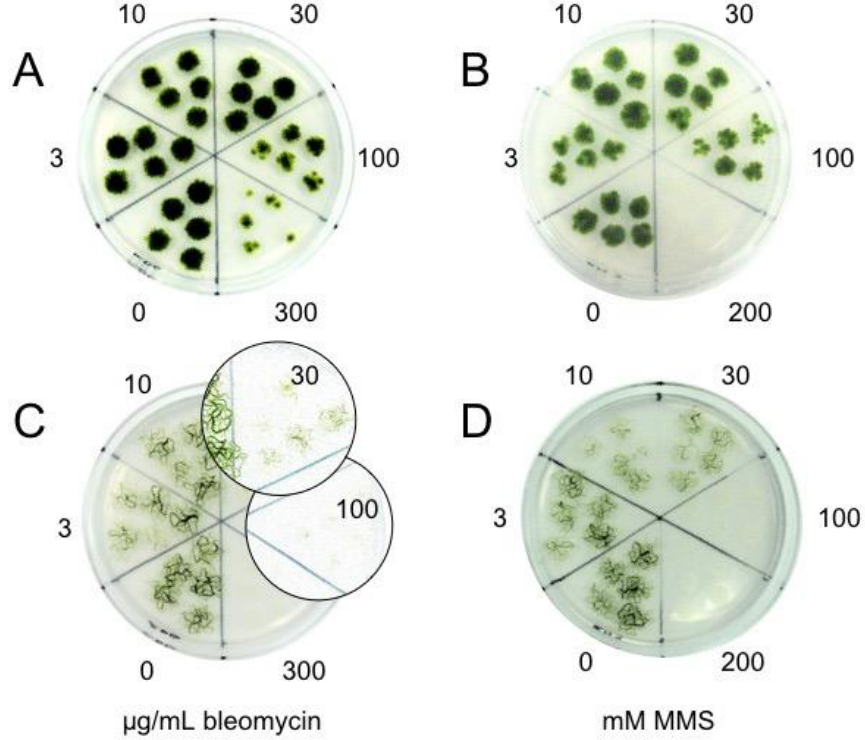
Figure 2. Sensitivity of the K. flaccidum K101 ( A , B ) and Zygnema sp. Z436 ( C , D ) to bleomycin ( A , C